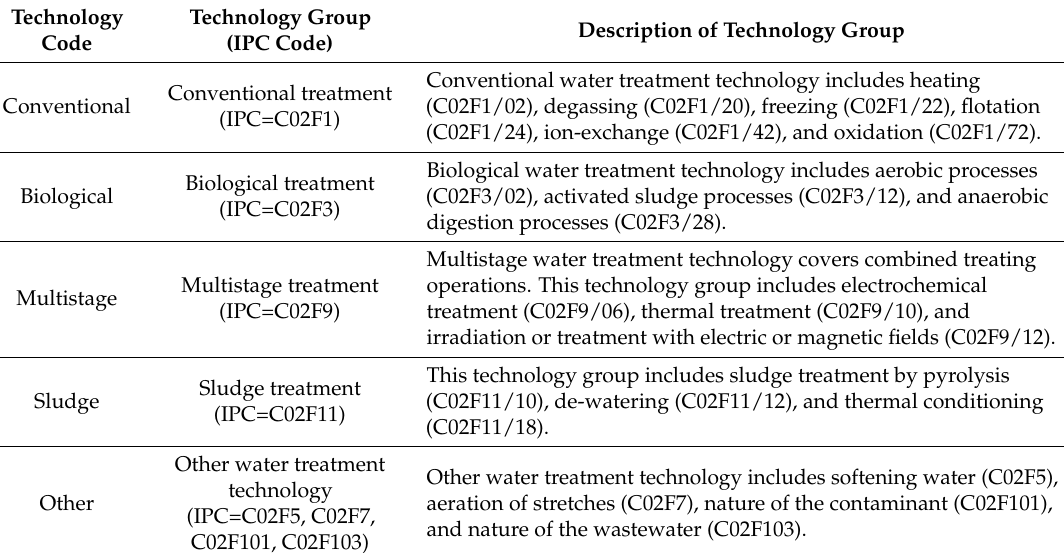
Table 1. Description of water treatment technology